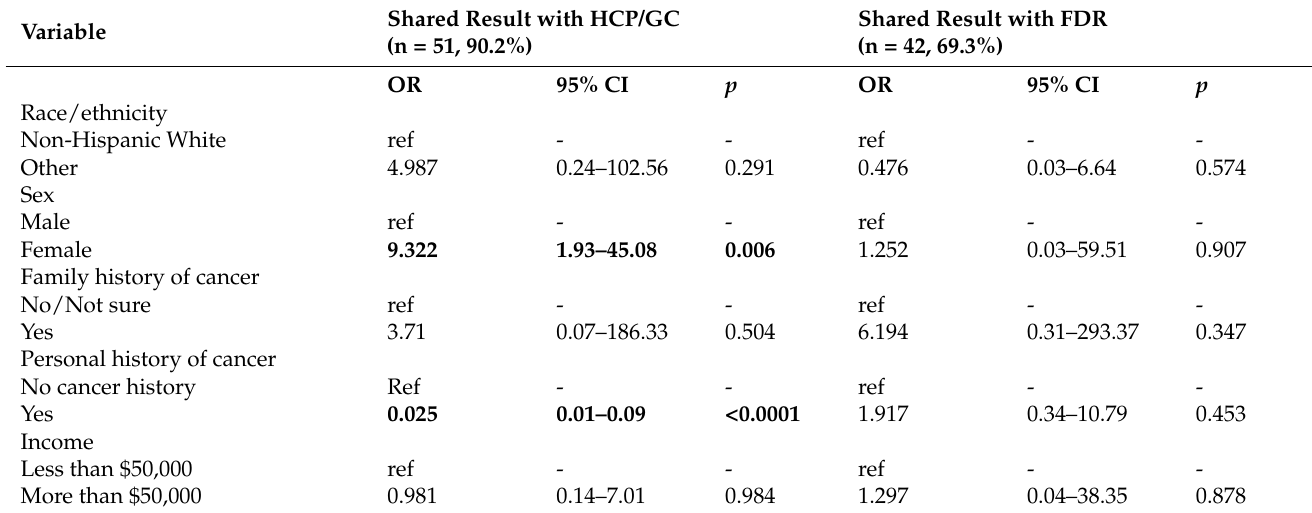
Table 2. Logistic regression of sharing high-risk cancer genetic test